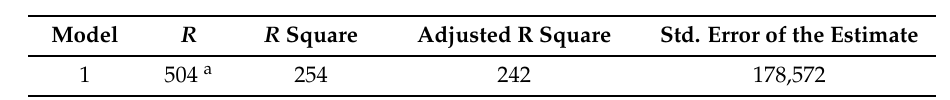
Table C1. Model summary b .